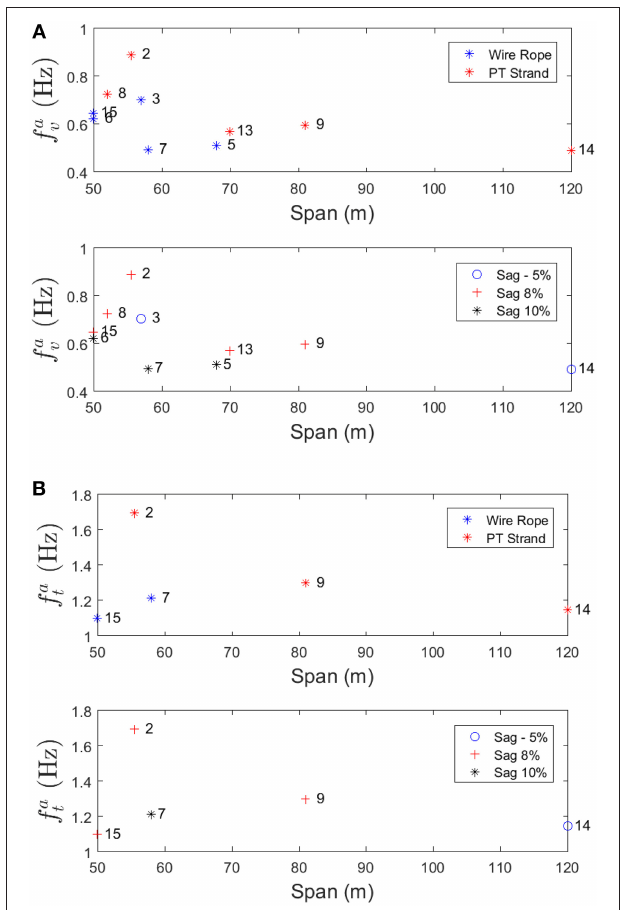
FIGURE 11 | Measured VS (A) and VA (B) frequencies alongside the values predicted from Equations (1,